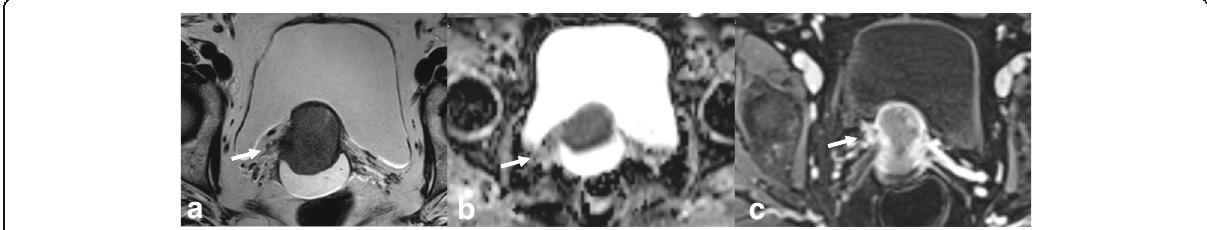
Fig. 14 Tumor visualization with axial oblique T2WI ( a ), DWI-ADC map ( b ), and DCE imaging ( c ) reveals loss of the hypointense cervical rim on the right lateral aspect of the cervix, with an irregular interface between the tumor and the parametrium (arrow). ADC map shows diffusion restriction, and DCE imaging reveals enhancement of the right lateral wall indicating early parametrial invasion